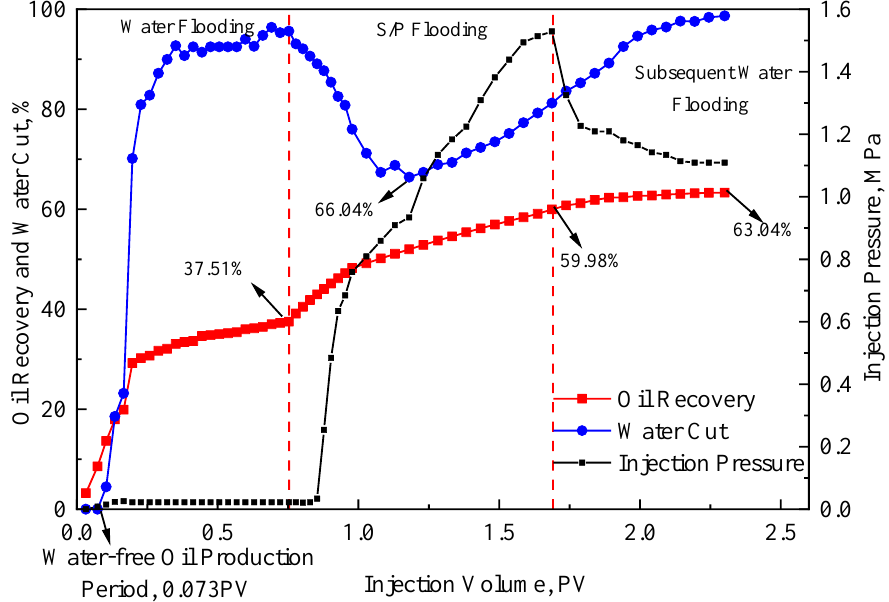
Figure 13. The injection pressure, water cut, and oil recovery of S/P flooding of five-spot well pat-